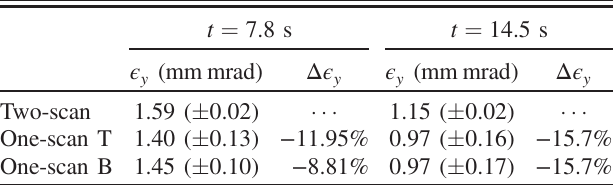
TABLE II. Comparison of results from the single-scan Gaus- sian algorithm with the two-scan method. One-scan T and B refer to scraping from the top and bottom, respectively. Δ ϵ y refers to the difference from the two-scan results.